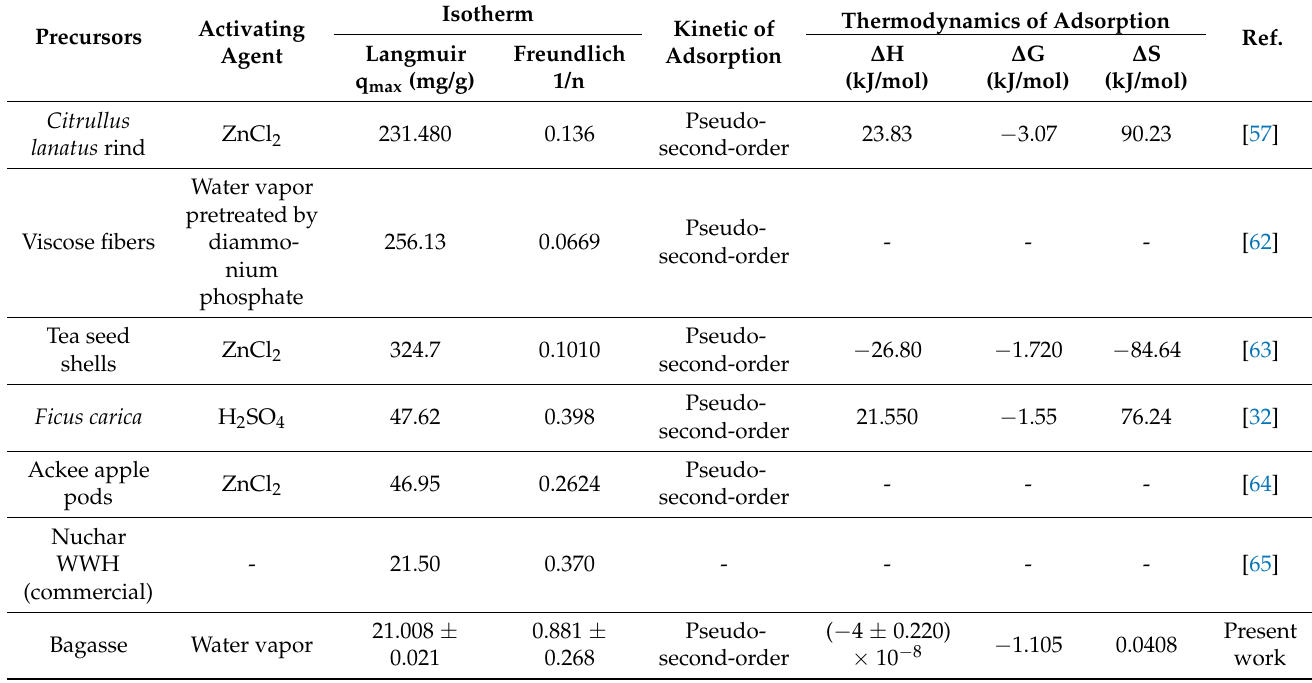
Table 5. The summarized literature data on MB adsorption onto carbon